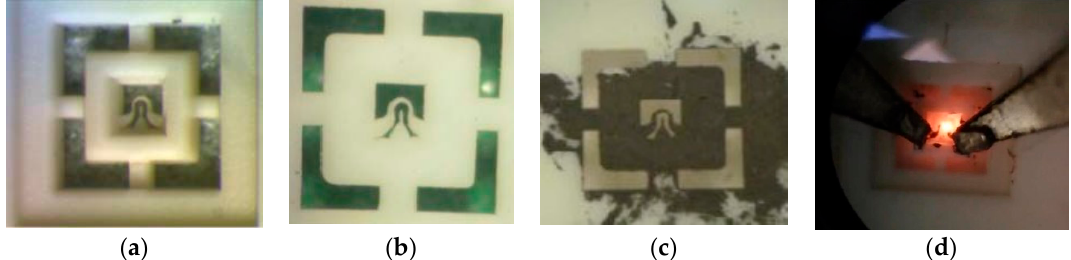
Figure 3. ( a )—Bottom view of MEMS microhotplate after laser micro milling. Chip size 1 × 1 mm by border of internal frame; ( b )—Top view of MEMS. Internal window size 0.3 × 0.3 mm. Central track width is 30 µm; ( c ) Microheater track width 30 µm under cower Pt paste; ( d ) Testing MEMS microhotplate under voltage load (pins). Hot area at ≈ 600 °C.